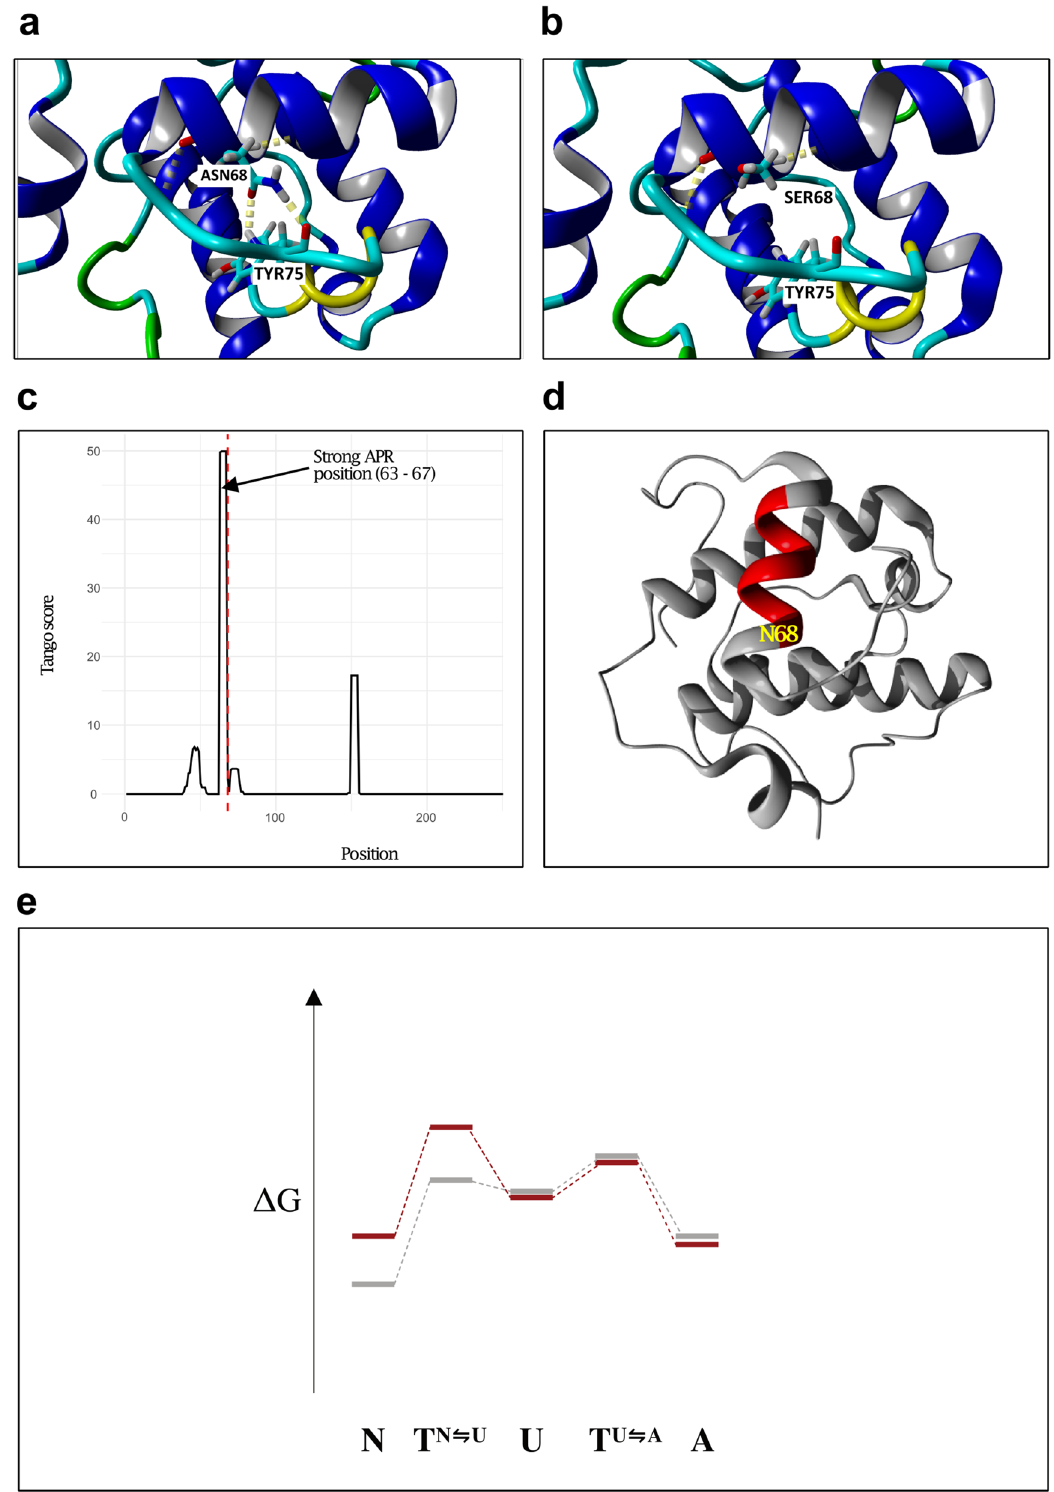
Figure 2. Modelling of the MAPRE2 N68S mutation. ( a , b ) The size and hydrophobicity difference between ( a ) wild type (Asn) and ( b ) mutant (Ser) residue makes the mutant unable to form the same hydrogen bonds. ( c ) Aggregation propensity prediction TANGO scores per residue for wild type MAPRE2. Vertical red line indicates the position of N68. ( d ) Model structure of MAPRE2 with the strong APR colored in red. ( e ) Energetic landscape of the mechanism proposed. N68S mutation is indicated in red and wild type energy landscape in grey. N68S thermodynamically destabilizes and kinetically slows down the folding reaction, resulting in higher energies for N and T N ⇋ U and less natively folded protein ( N native fold, U unfolded state, A aggregated state, T transition